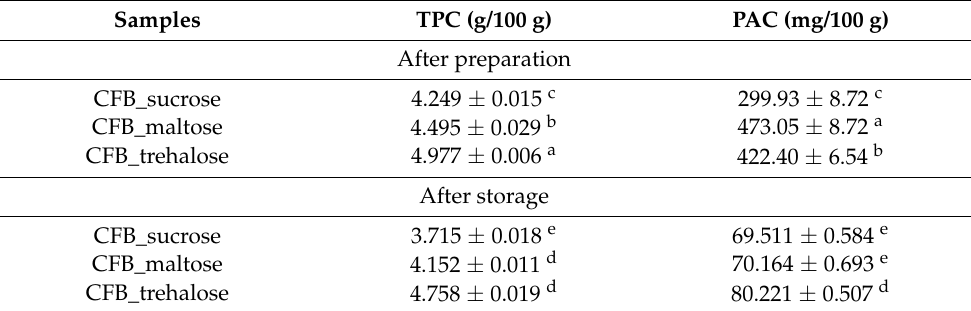
Table 1. Total phenolics (TPC) and proanthocyanidins (PAC) content in citrus fiber-blackberry cream fillings with the sucrose, maltose and trehalose after preparation and after storage for three months.